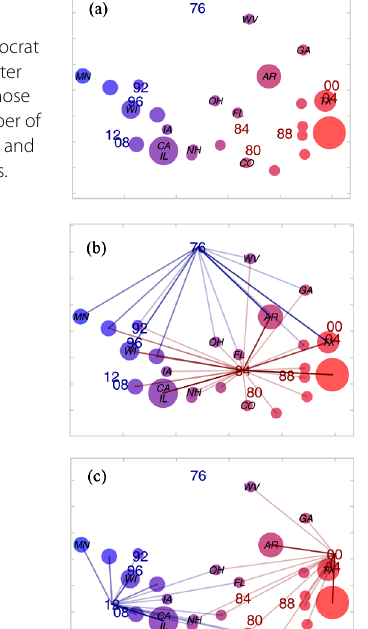
Figure 2 BiFold bubble plot of US presidential election voting - by state (1976-2012). The BiFold layout based on state voting records, where b ij = 1 if state i voted for the winning candidate in election j . Bubble size (area) is proportional to the number of states at that position, with the smallest circle indicating one state. Each two-digit year is positioned at the BiFold coordinates of the elected president.